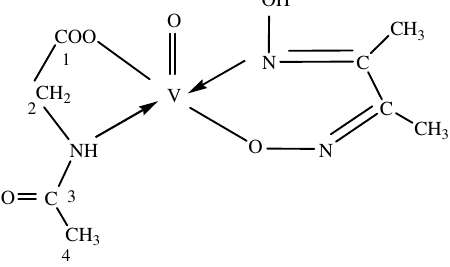
Figure 1. Square pyramid geometry for the [VO(D)(G)] complex